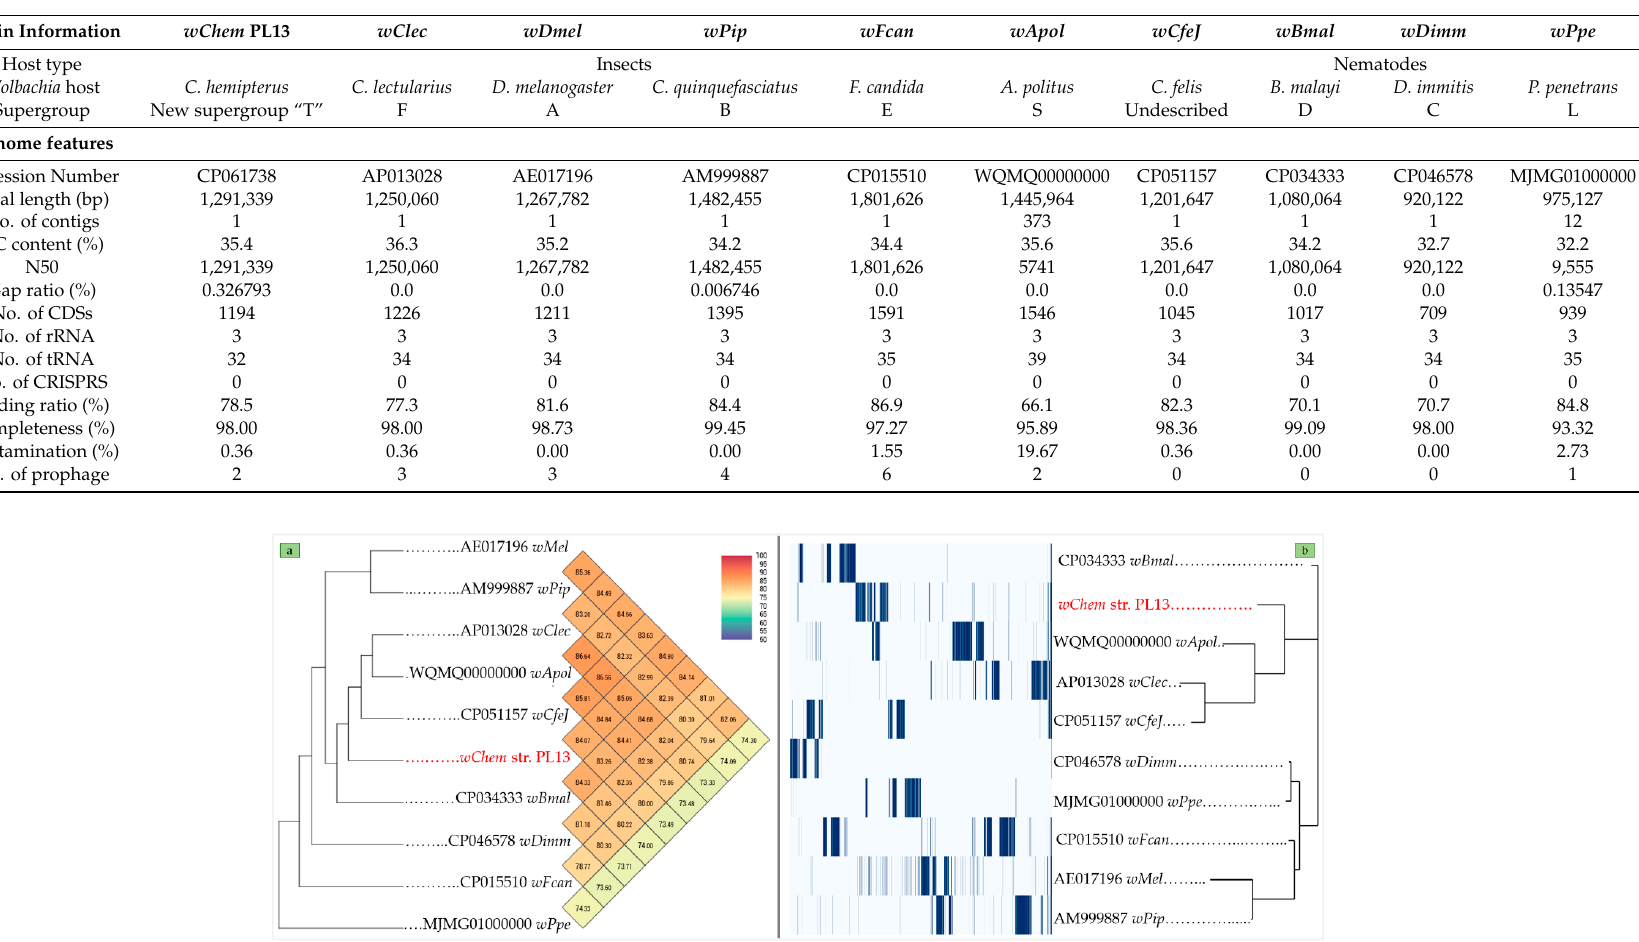
Figure 3. ( a ). heatmap generated with Ortho-ANI values between the wChem PL13 strain and the other Wolbachia supergroups. ( b ). pan-genome analysis of wChem PL13 strain based on the maximum likelihood tree from the accessory genome elements (right). The presence (blue) and absence (white) of accessory genome elements are presented on the left matrix.